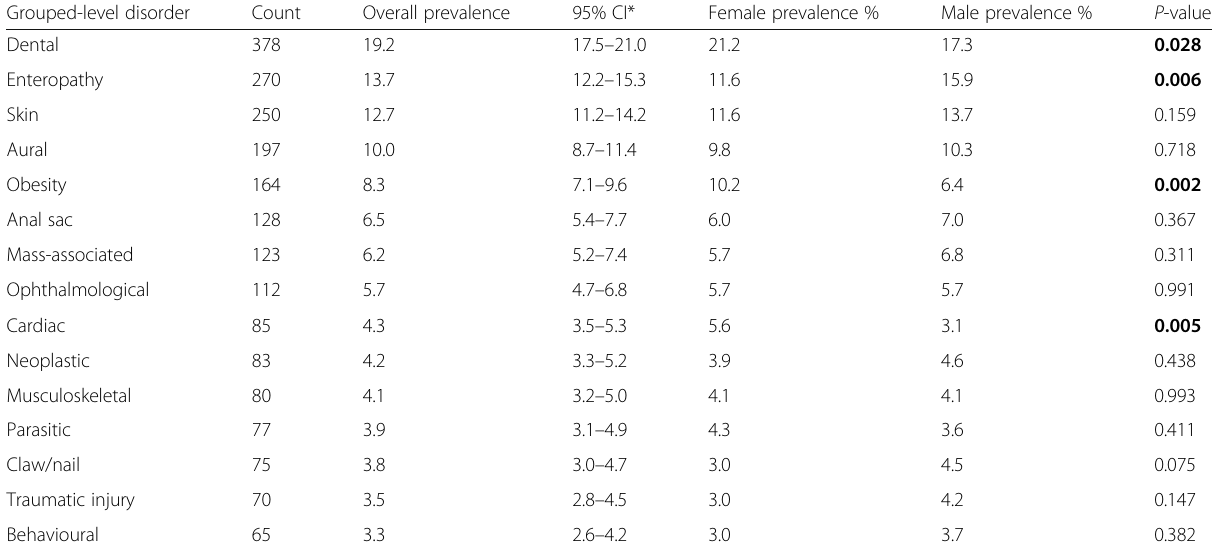
Table 4 Prevalence of the most common grouped-level disorders recorded in Miniature Schnauzers ( n = 1972) attending UK primary-care veterinary practices participating in the VetCompass ™ Programme from January 1st, 2013 to December 31st, 2013 Grouped-level